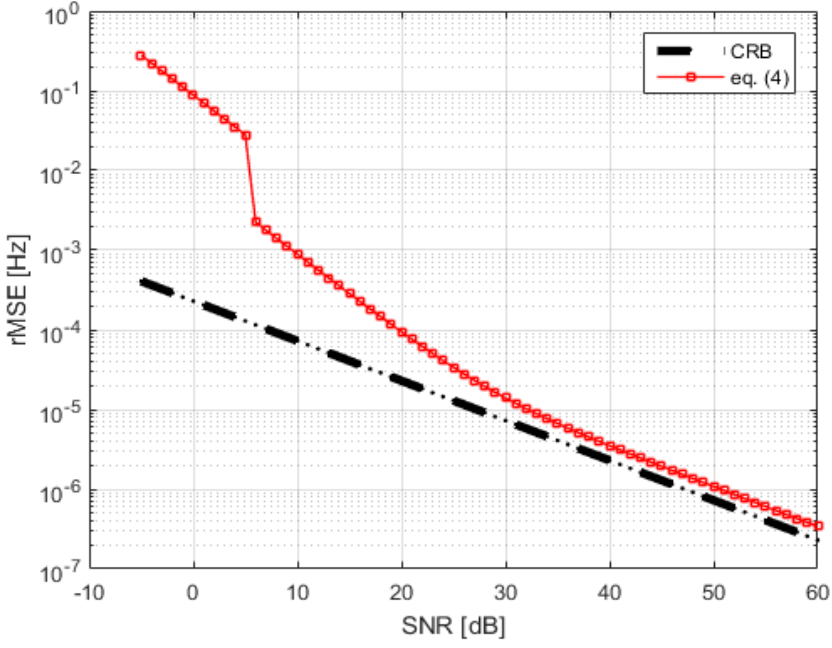
Figure 5. CRB and Equation (4) vs. SNR for K =